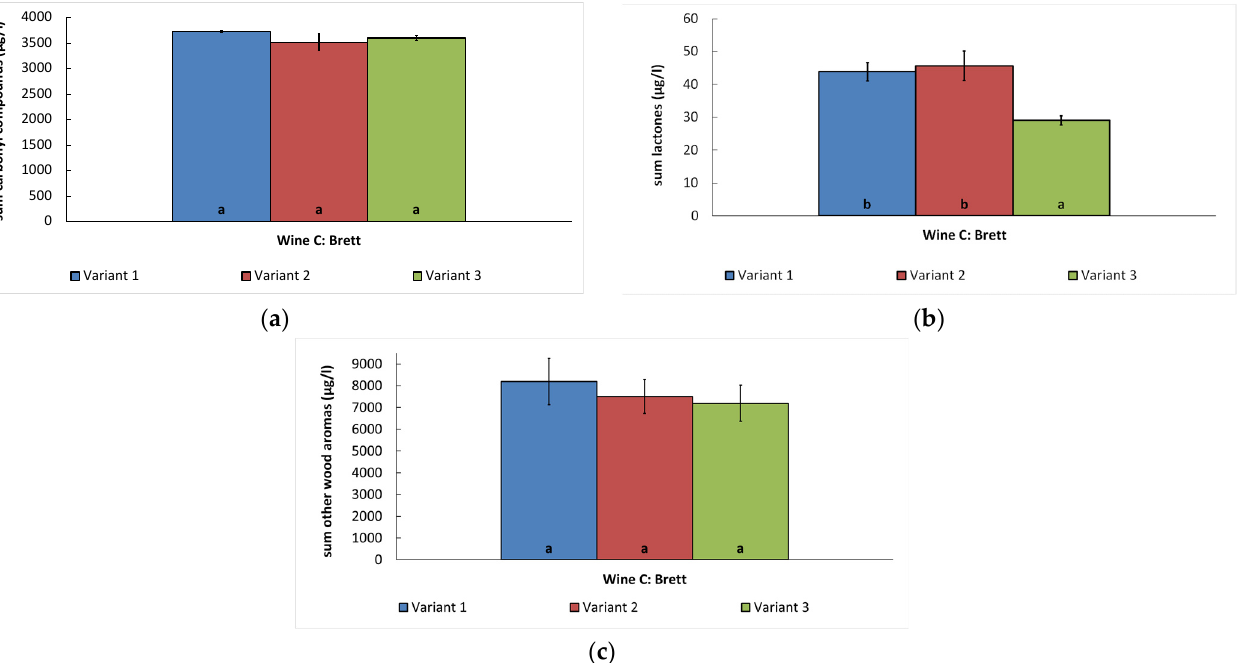
Figure 5. Reduction in wood aroma substances by filtration with conventional EKS layers (variant 2) and Fibrafix ® TX layers (variant 3) compared with the control sample (variant 1) in the small-scale test. Wine A was spiked with geosmin, wine B with TCA, and wine C with impact compounds of the “animal” phenolic character (Brett); ( a ) sum of carbonyl compounds; ( b ) sum of lactones; ( c ) sum of other wood aroma substances. Significance test using simple ANOVA and post hoc test Tukey B test. Same letters mean no significant difference based on significance level p ≤ 0.05 with alphabetical order, starting with a (smallest value) to c (largest value).